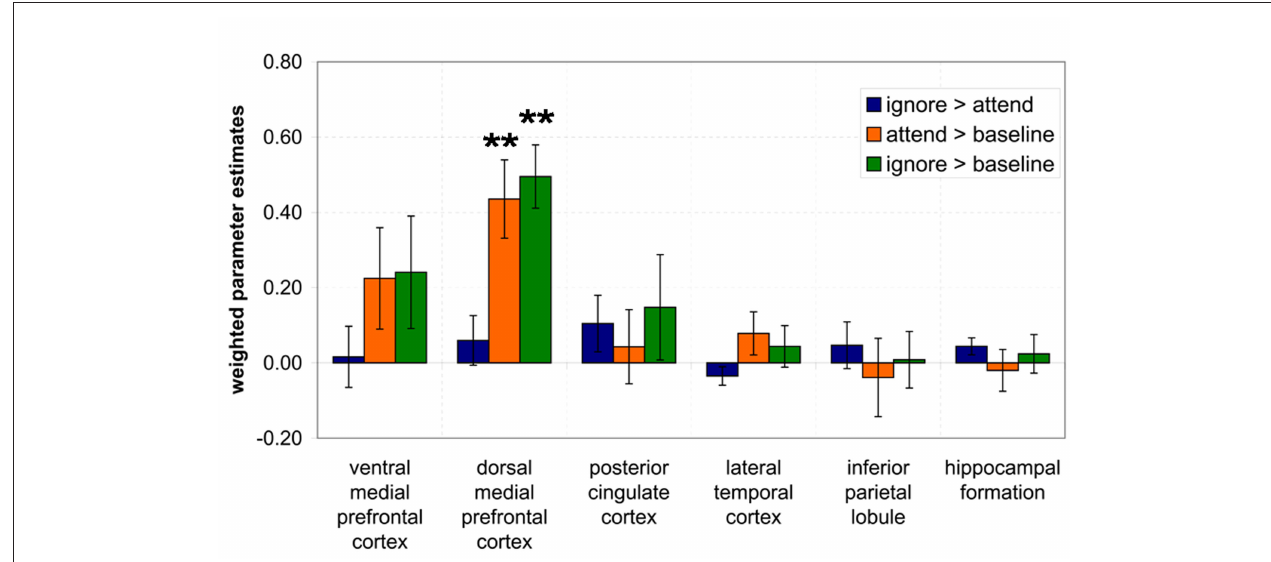
FIguRe 3 | Results of ROI analysis using typical DMN ROIs. Weighted contrast parameter estimates were extracted from three contrasts ([ignore > attend], [attend > baseline], [ignore > baseline]) and entered into a one-sample t -test. * p < 0.008, ** p <